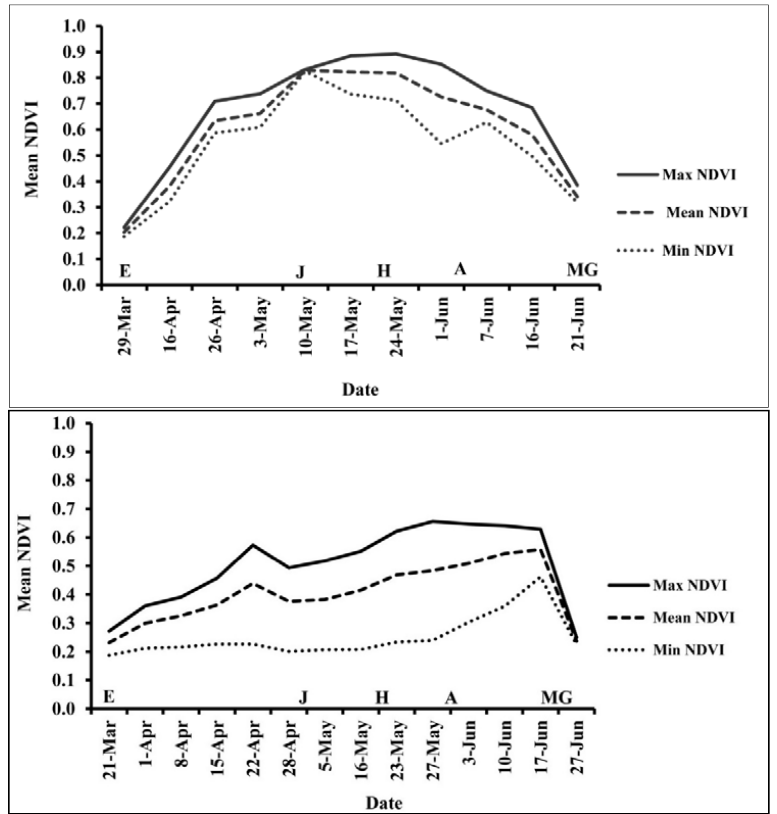
Figure 2. Individual winter wheat genotype (CO940610) selected across the growing season shows the characterization of the generalized wheat crop growth-curve on the basis of the time-series of maximum, mean, and minimum of NDVI readings for the site I (top) (NDVI readings obtained for 11 dates) and for site II (NDVI readings for 14 dates) (bottom). Critical growth stages are indicated as A = anthesis (60-69 Zadoks Scale for growth stage) growth stage, E = early spring (26-29 Zadoks Scale for growth stage) growth stage, J = jointing (30-39 Zadoks Scale for growth stage) growth stage, H = heading (50-59 Zadoks Scale for growth stage) growth stage, and MG = mid-grain filling (70-77 Zadoks Scale for growth stage) growth